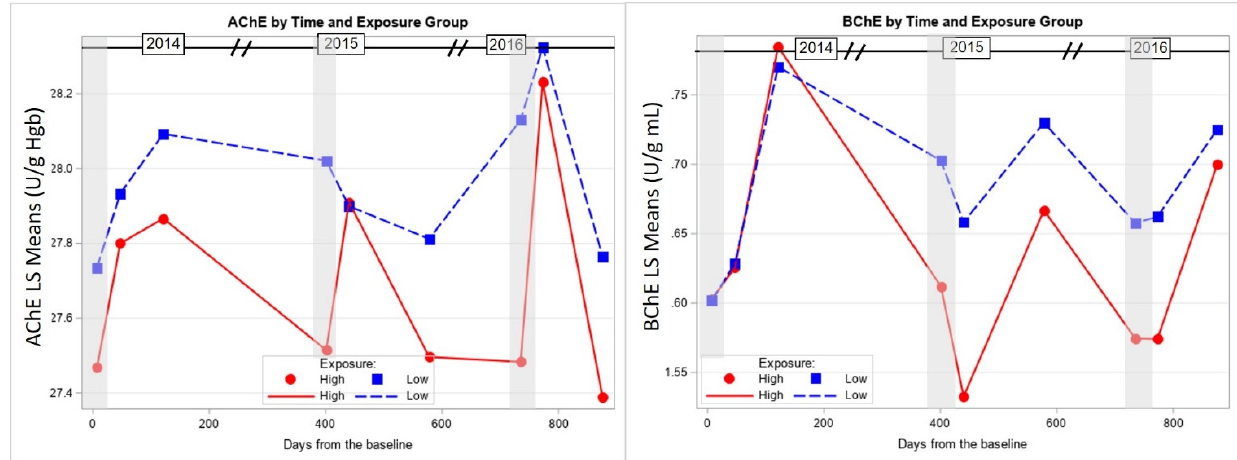
Figure 3. Least squares mean cholinesterase activity (BChE and AChE) of the study group across the 3-year study period stratified by the high and low CPF exposure group. Shaded areas indicate the times of CPF application.